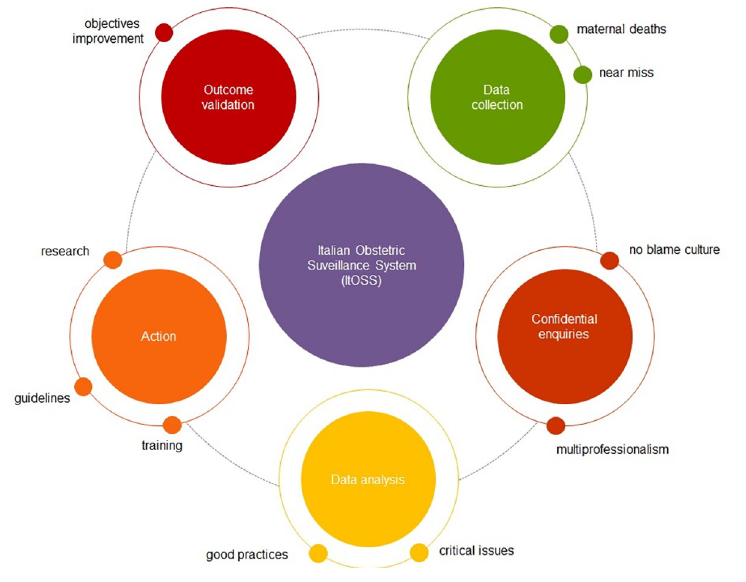
Fig 1. The ItOSS surveillance